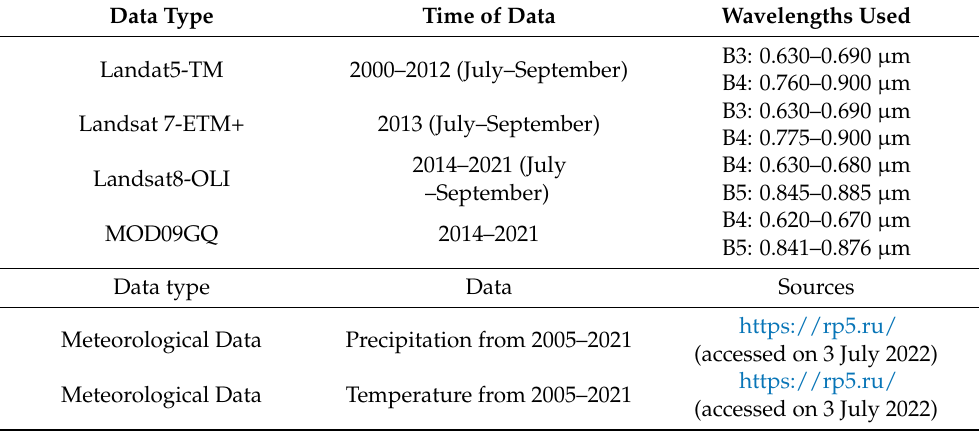
Table 1. Information on the data used in the